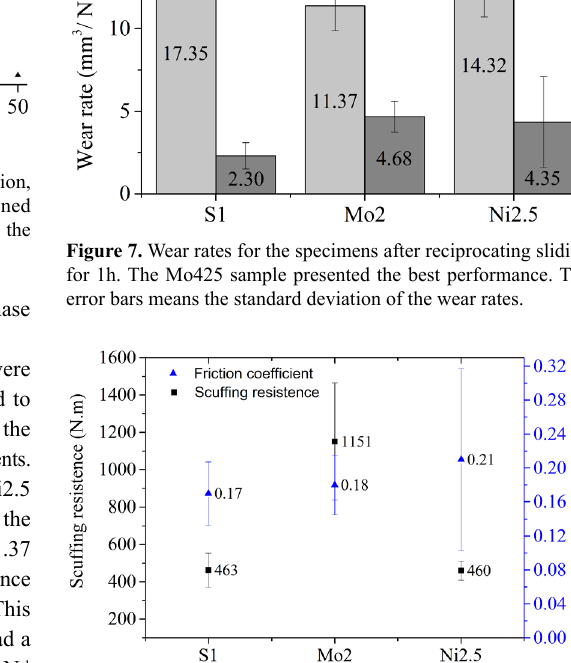
Figure 8. Friction coefficient and scuffing resistance of the samples. The enrichment with molybdenum maintained the coefficient of friction value and increased the scuffing resistence in relation to sample S1. The error bars means the standard deviation of the mean.